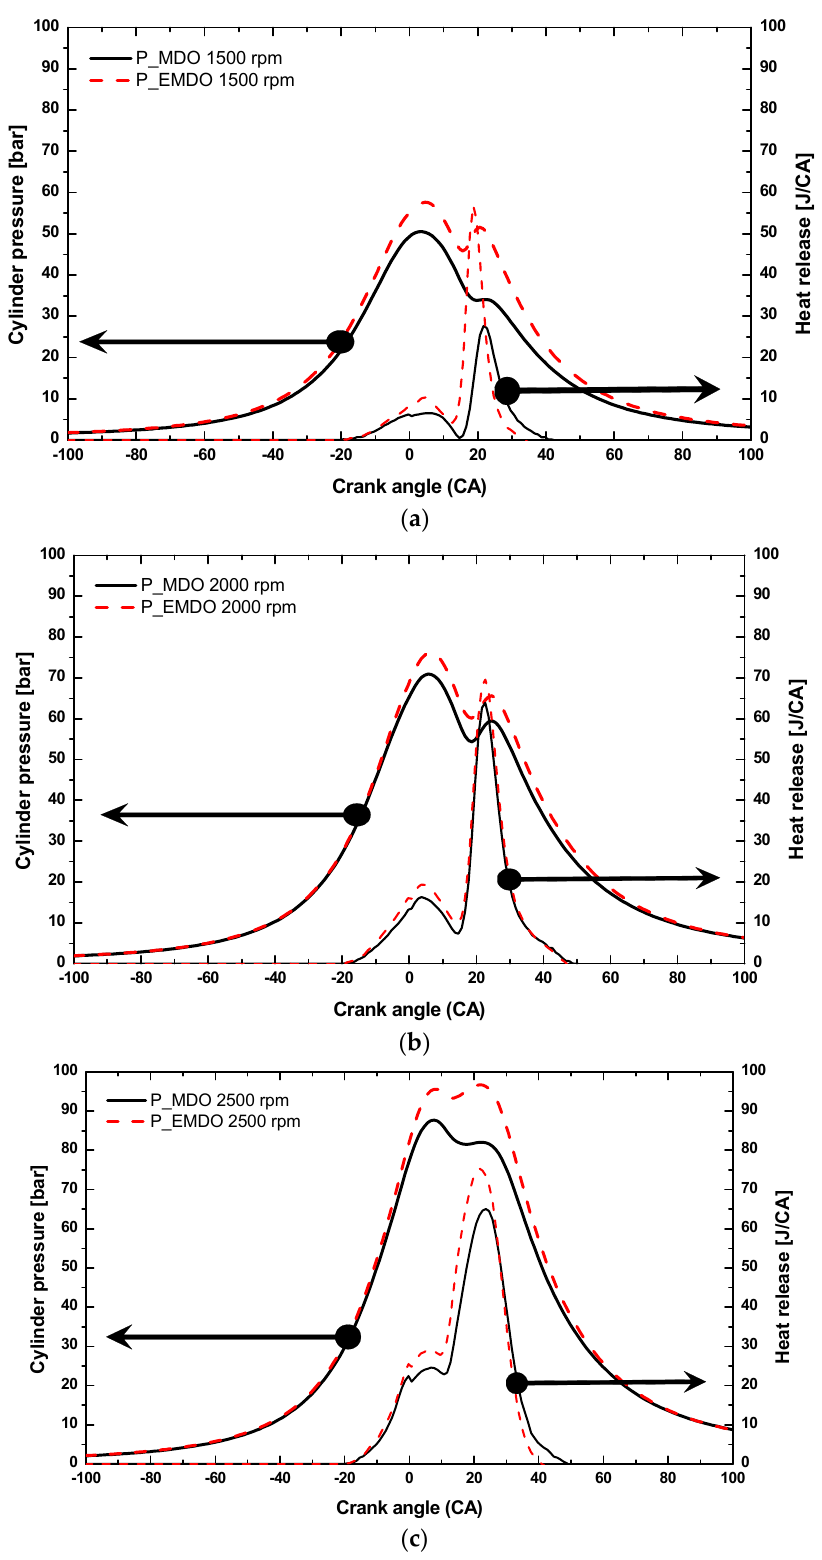
Figure 4. Characteristics of the cylinder pressure and heat release with marine diesel oil (MDO) and emulsified MDO (EMDO) in accordance with changing rpm: ( a ) 1500 rpm; ( b ) 2000 rpm; ( c ) 2500 rpm.